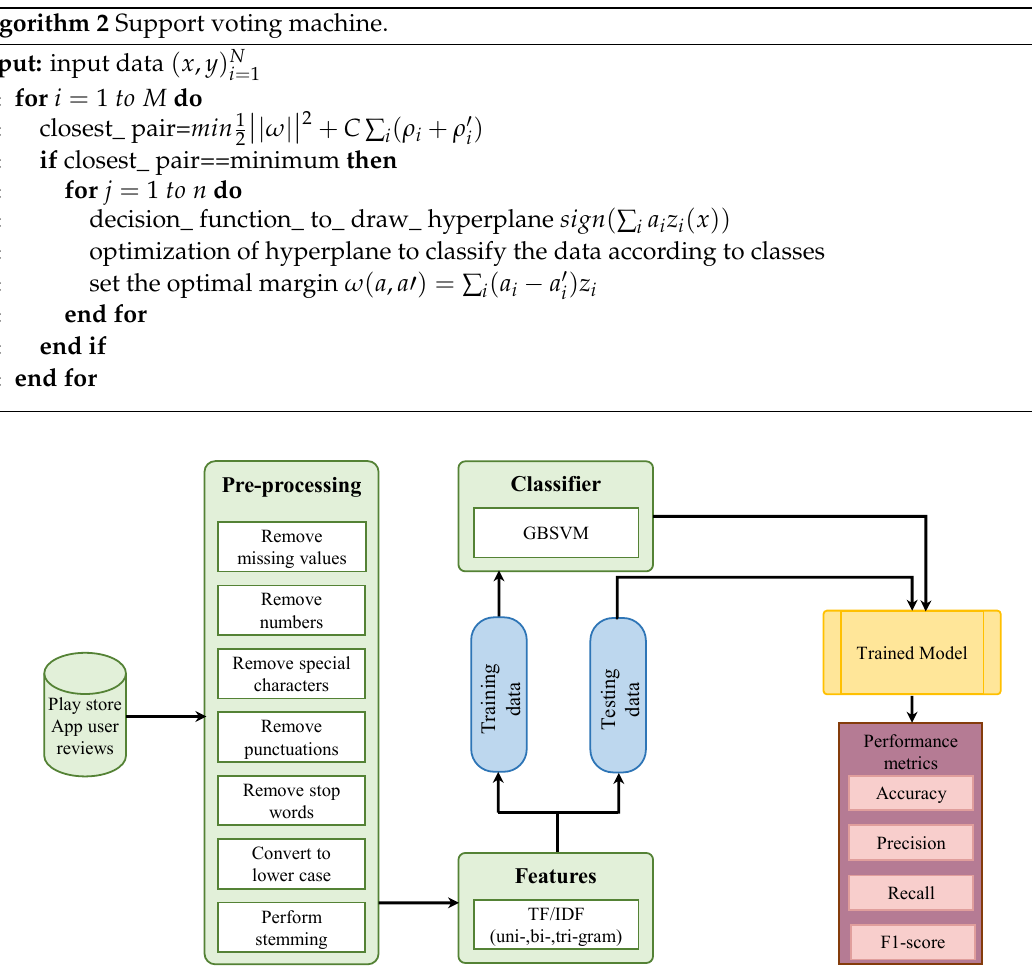
Figure 3. Diagram for the proposed methodology. Initially pre-processing is carried out to remove noise and unnecessary data. Term Frequency-Inverse Document Frequency (TF-IDF) features are then extracted to train the classifiers. For evaluation train-test split is done as